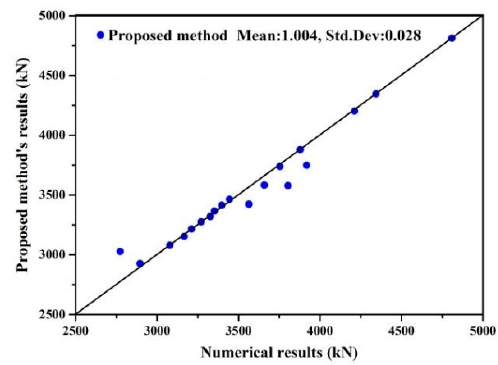
Figure 23. Comparison between numerical results and predictions by proposed methods. Table 3. Comparison of compressive resistance between calculated and numerical results.